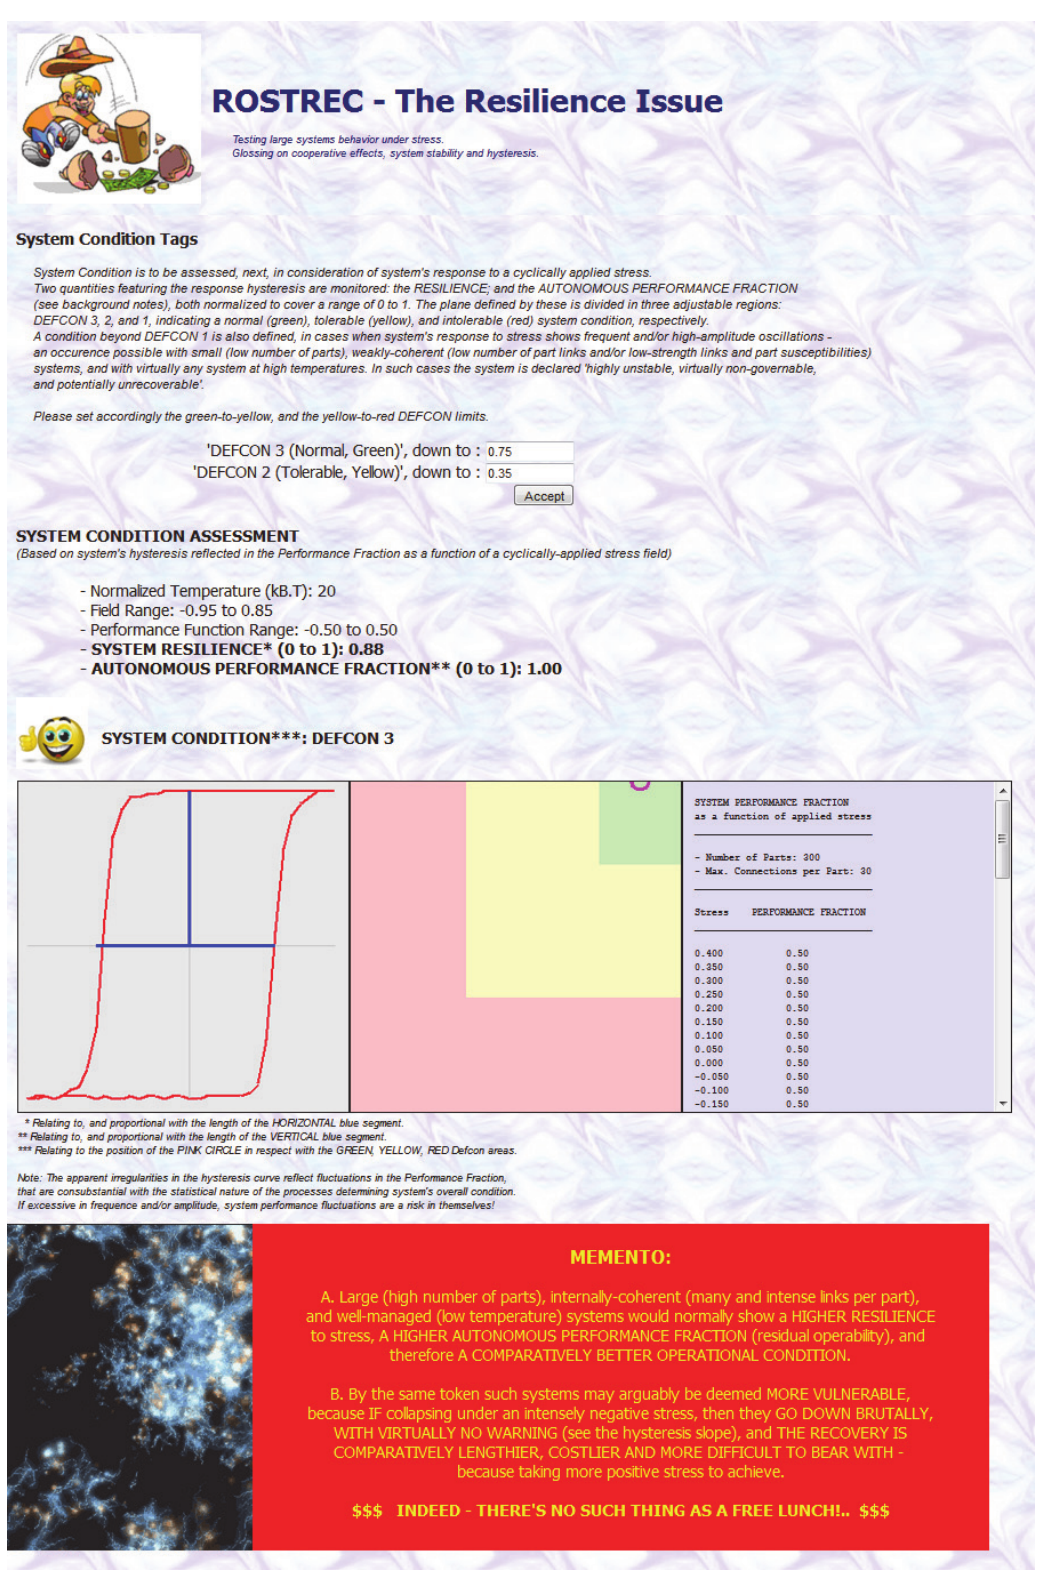
Figure 7 . Interface web page, of an interactive game implementing the microscopic